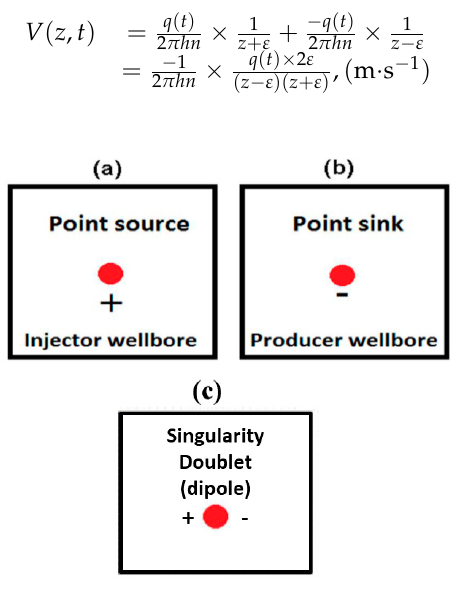
Figure 7. ( a ) Point sources and ( b ) point sink, superposed to form ( c ) singularity dipole (adapted from Weijermars and Van Harmelen [79]).